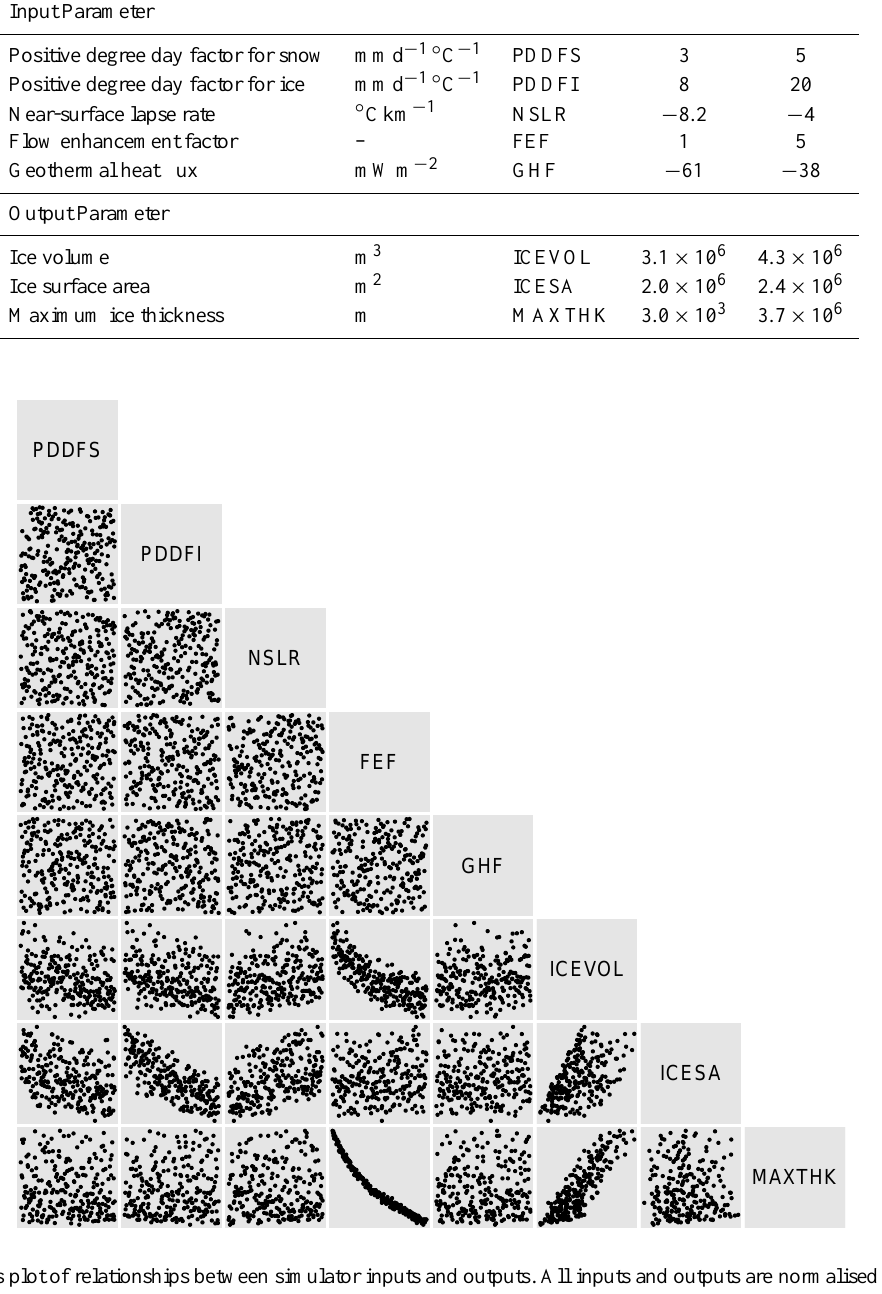
Fig. 2. Summary pairs plot of relationships between simulator inputs and outputs. All inputs and outputs are normalised to a zero-one scale, relative to the limits of the ensemble.